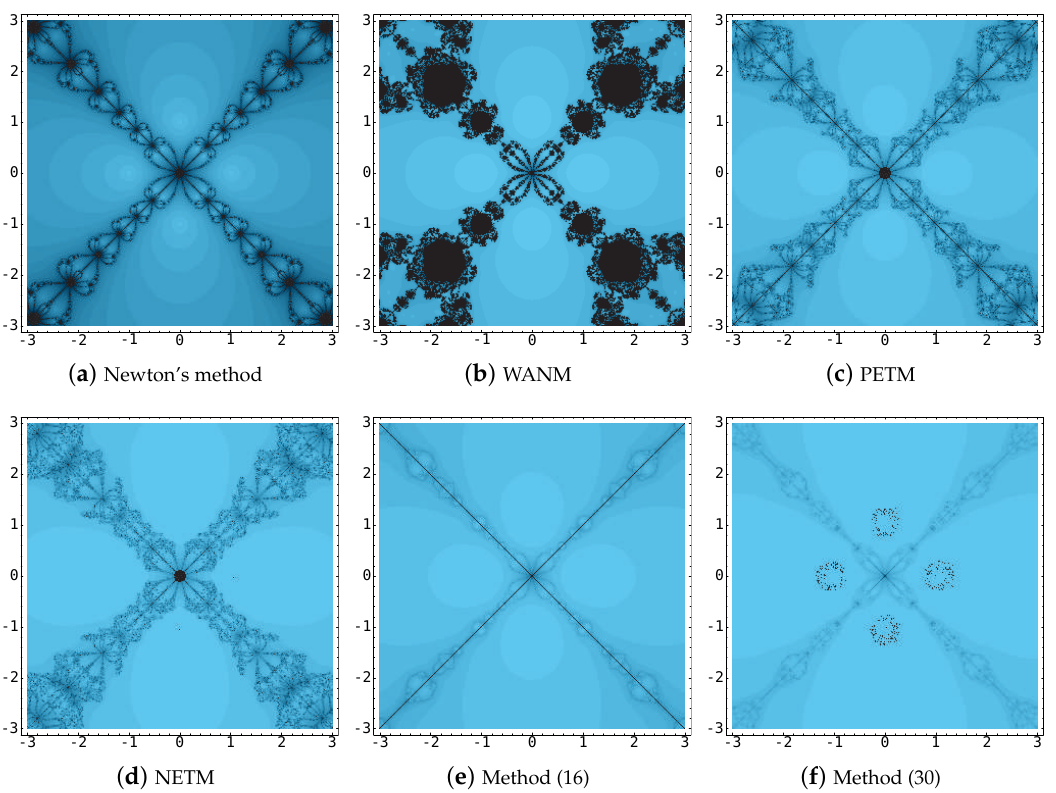
Figure 3. The results are for the polynomial z 4 −